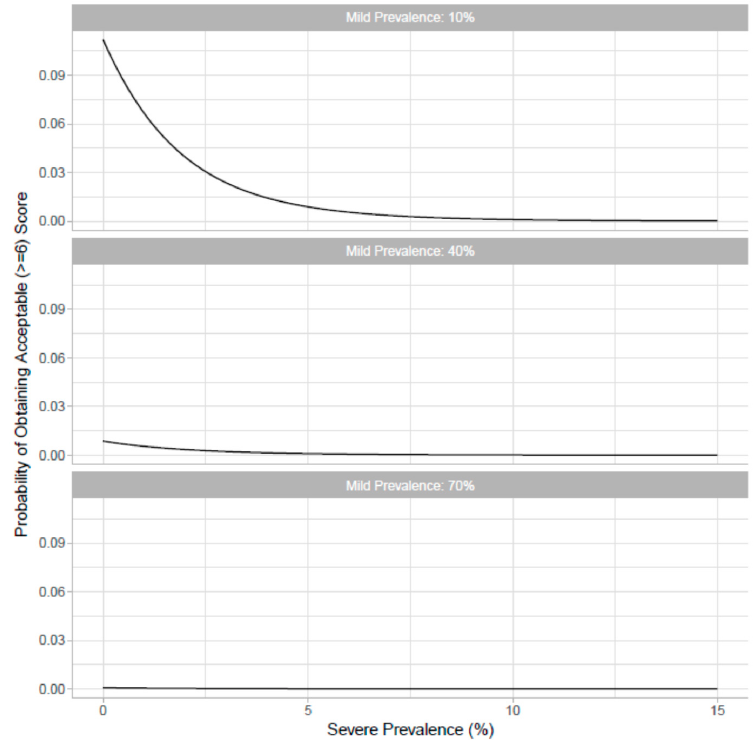
Figure 2. The probability of obtaining an “acceptable” score ( y axis; defined as a score ≥ 6), given increasing severe lameness ( x axis) and different prevalence of mild lameness (sub-plots). Probabilities are based on a cumulative link mixed